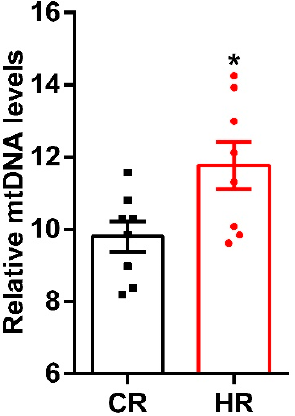
Figure 3. Relative mtDNA levels in the liver of animals. A real-time qPCR was carried out to determine the mtDNA copy number, which is calculated as the ratio mtRNA to nuclear GADPH. CR-control, HR-hyperthyroidism. *— p < 0.05 compared with the control data ( n = 8).